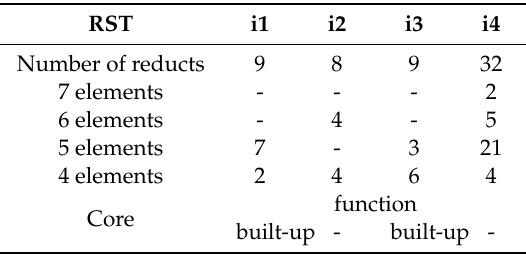
Table 2. Number, size, and cores of reducts designated by the RST method for the selection of buildings in four